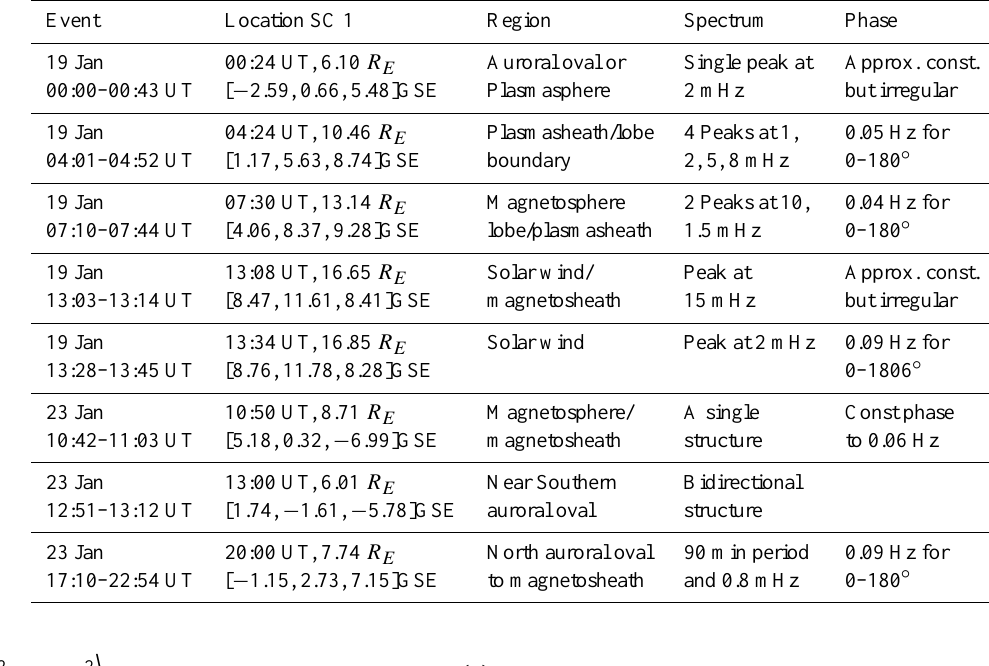
Table 1. Wave event